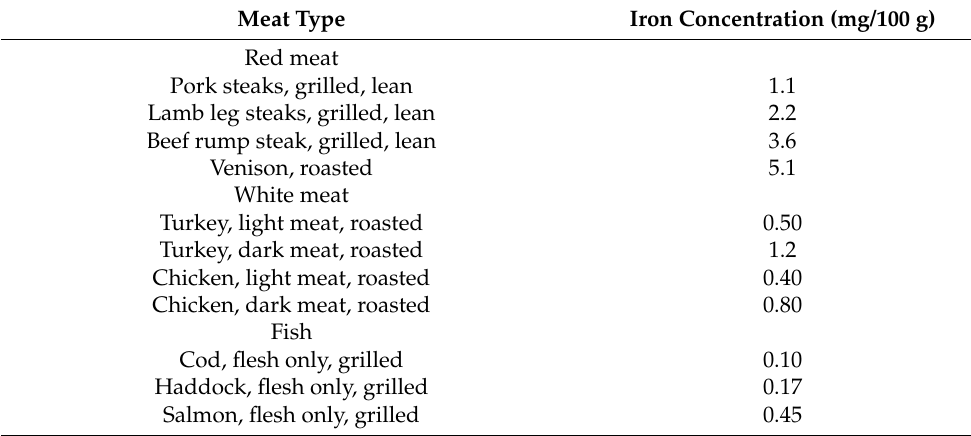
Table 1. Typical iron concentrations in a range of meat types (from